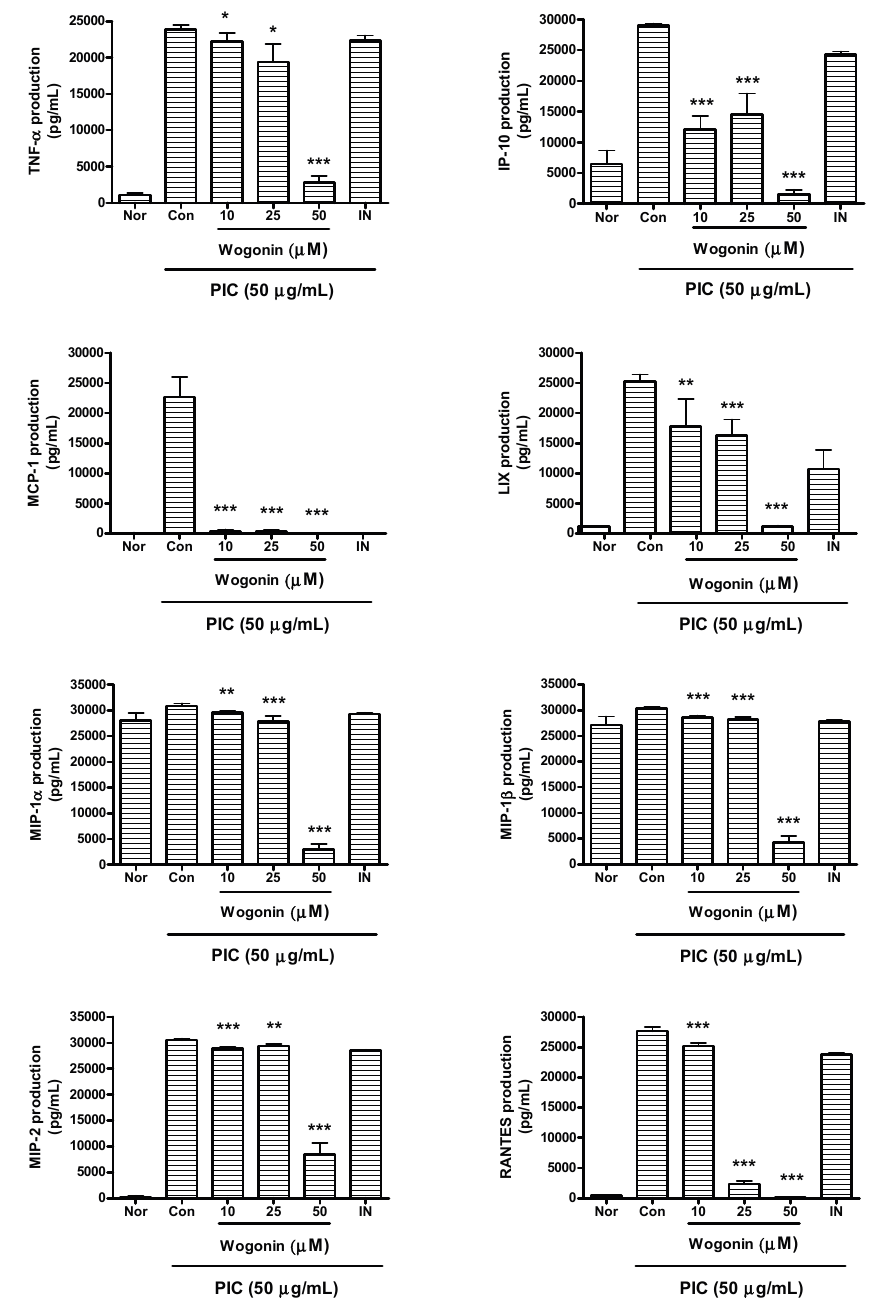
IN05000100001500020000250003000035000 Figure 4. Effects of wogonin on production of cytokines such as TNF- α , IP-10, MCP-1, LIX, MIP-1 α , MIP-1 β , MIP-2, and RANTES/CCL5 in dsRNA-induced RAW 264.7 mouse macrophages. Flourescene intensity of each cytokine in the culture medium was measured by a Multiplex bead-based cytokine assay after 24 h incubation. Normal group (Nor) was treated with media only. Control group (Con) was treated with PIC (the synthetic analog of dsRNA, 50 µg/mL of polyinosinic-polycytidylic acid) alone. IN denotes indomethacin (0.5 µM). Values are the mean ± SD of three independent experiments. * P < 0.05 vs. Con; ** P < 0.01; *** P <